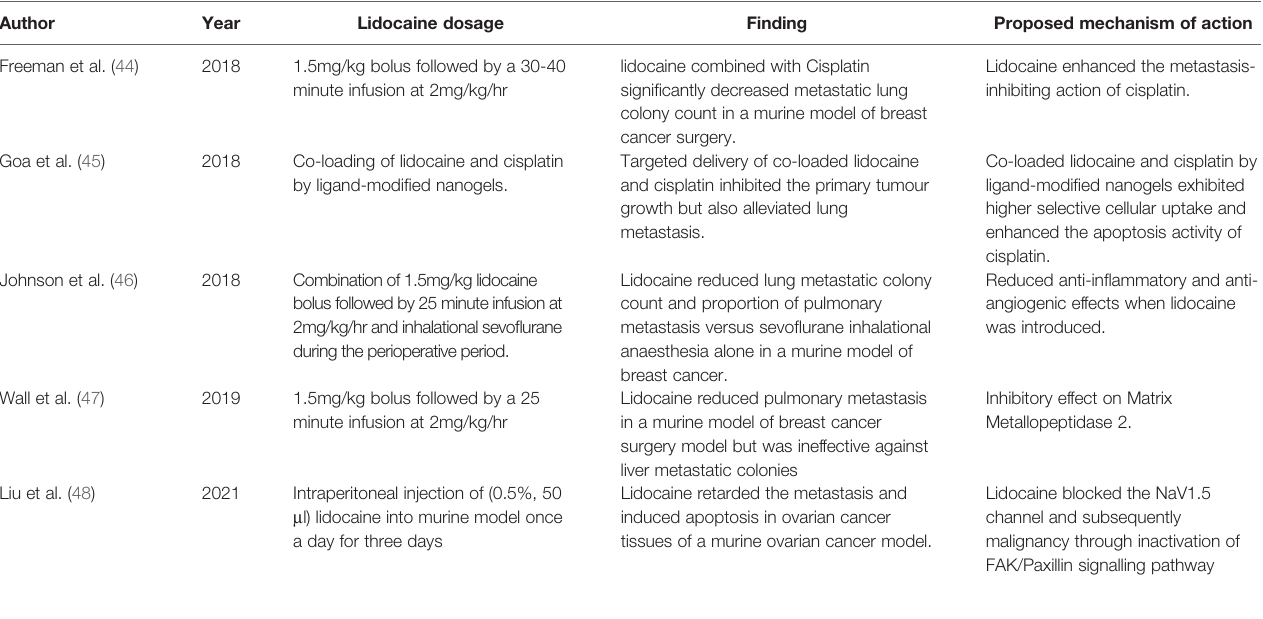
TABLE 1 | Selected summary of recent in vivo studies investigating the antitumour effects of